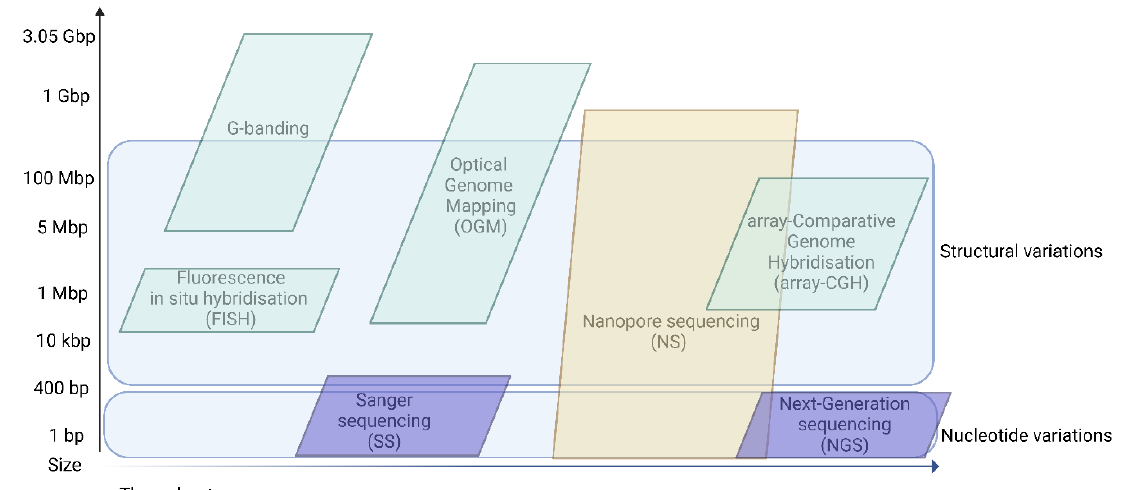
Figure 1. Reliable detection of genetic variants by size and technique throughput. Different techniques allow the detection of certain nucleotides or structural variants. The throughput of the different techniques also varies. Of note, throughput is also instrument-dependent, and this is not reflected entirely in the figure, as in some cases the instrumentation may change the throughput order represented in the figure. Created with BioRender.com. (accessed on 06 September 2022).